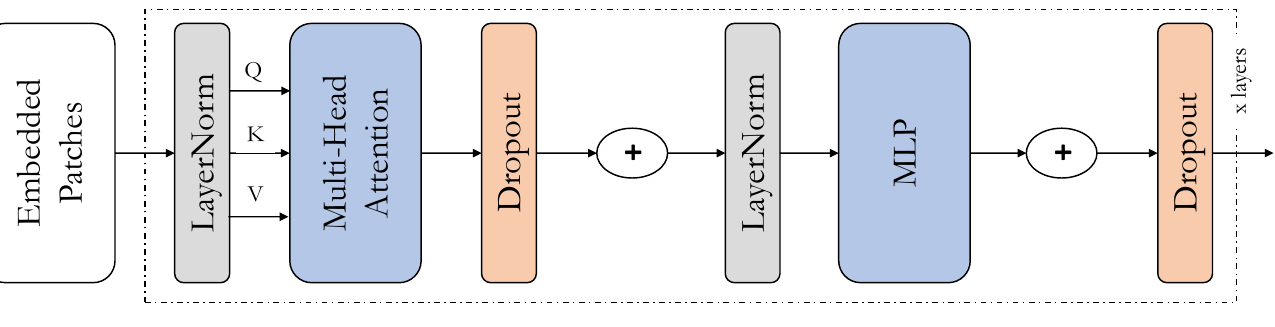
Figure 1. The architecture of the Vision Transformer.